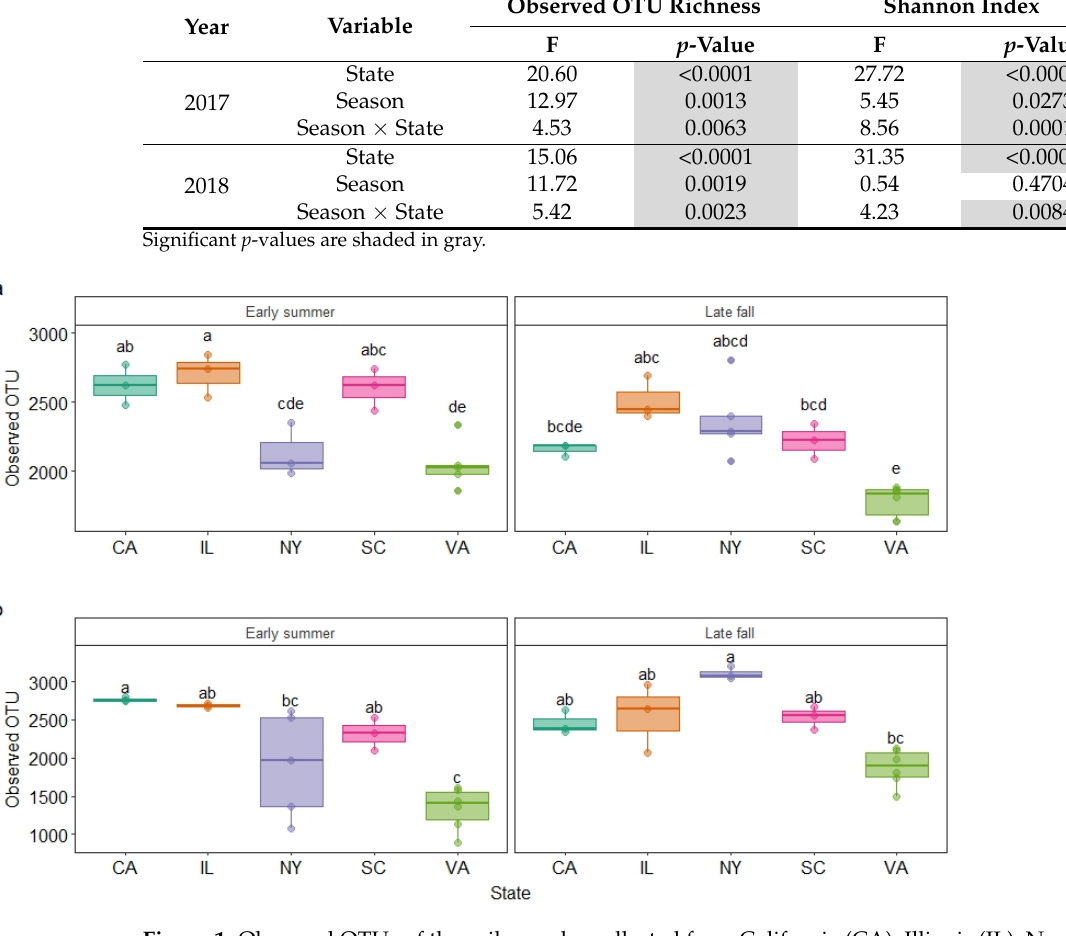
Figure 1. Observed OTUs of the soil samples collected from California (CA), Illinois (IL), New York (NY), South Carolina (SC), and Virginia (VA) in early summer and late summer of 2017 ( a ) and 2018 ( b ). Boxes topped by different letters within each season/year differed according to Tukey HSD post hoc test at p = 0.05.